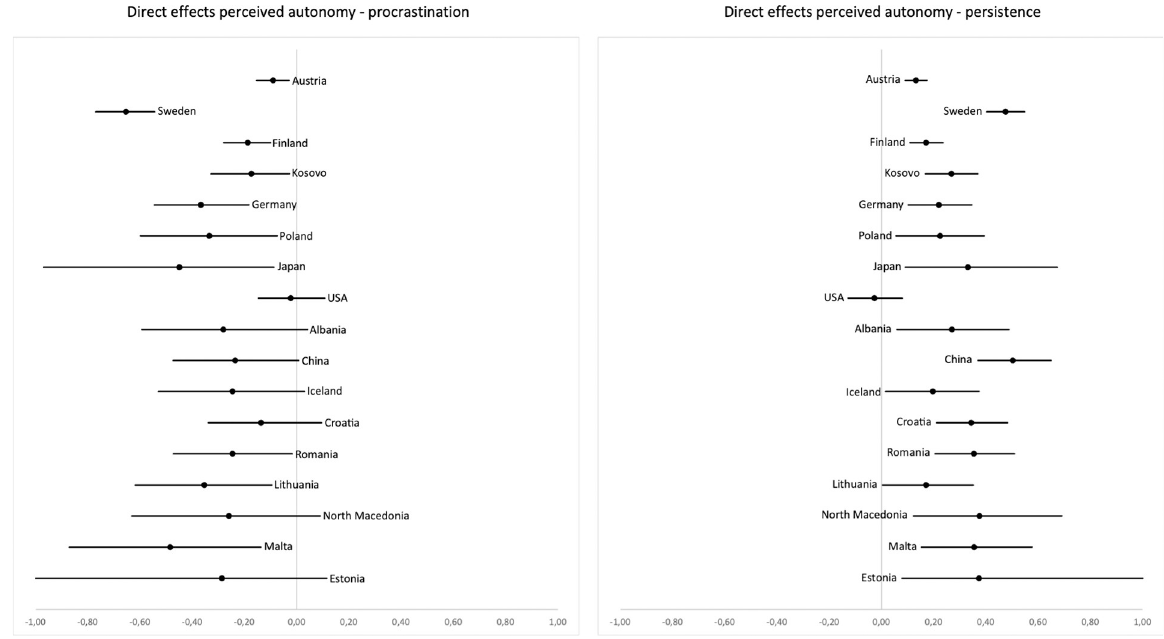
Fig 1. Unstandardized coefficients and two-sided 5% confidence intervals for the direct effects of perceived autonomy on procrastination (left) and persistence (right). Countries are ordered by sample size from top (highest) to bottom (lowest).